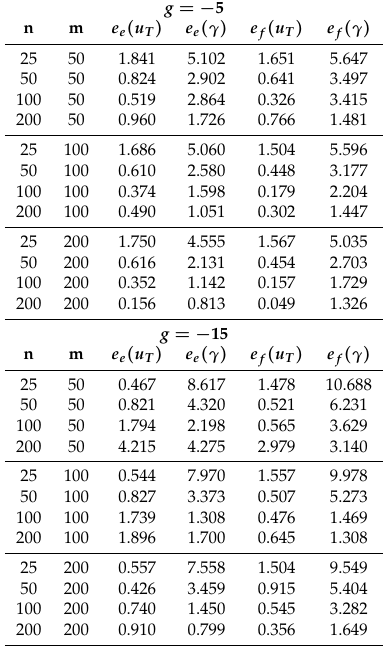
Table 2. One-dimensional problem with h-smoothing. Relative L 2 error for the temperature at the final time and phase change interface location with respect to the exact solution and a very fine grid